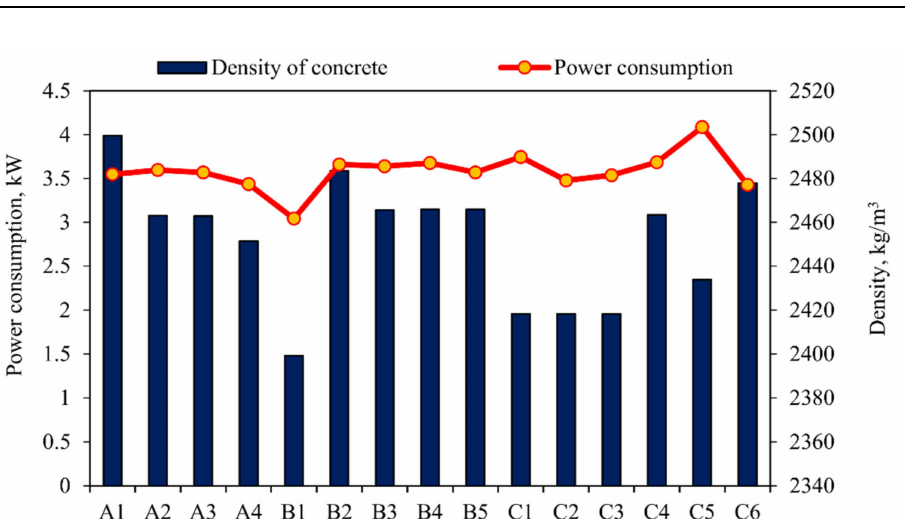
Figure 9. Power consumption versus density of